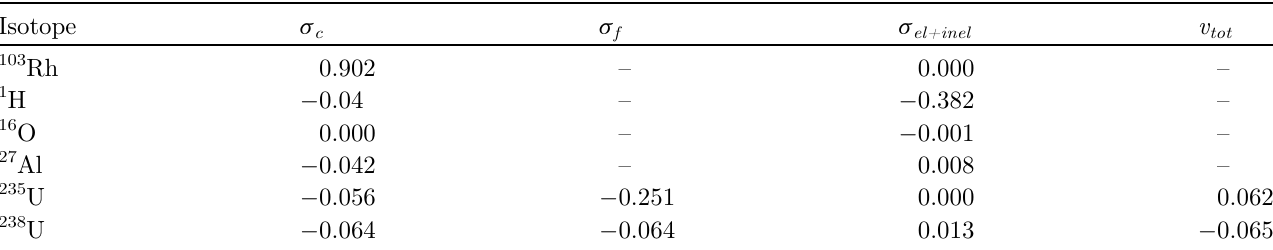
for the MAESTRO thermal-spectrum experiment. Rh